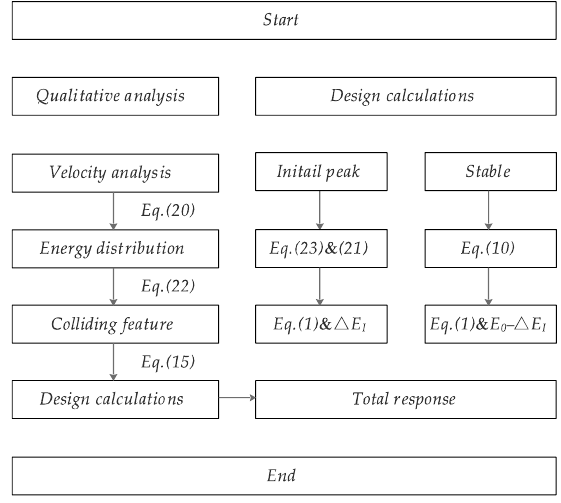
Figure 8. Design process of the two-step design.